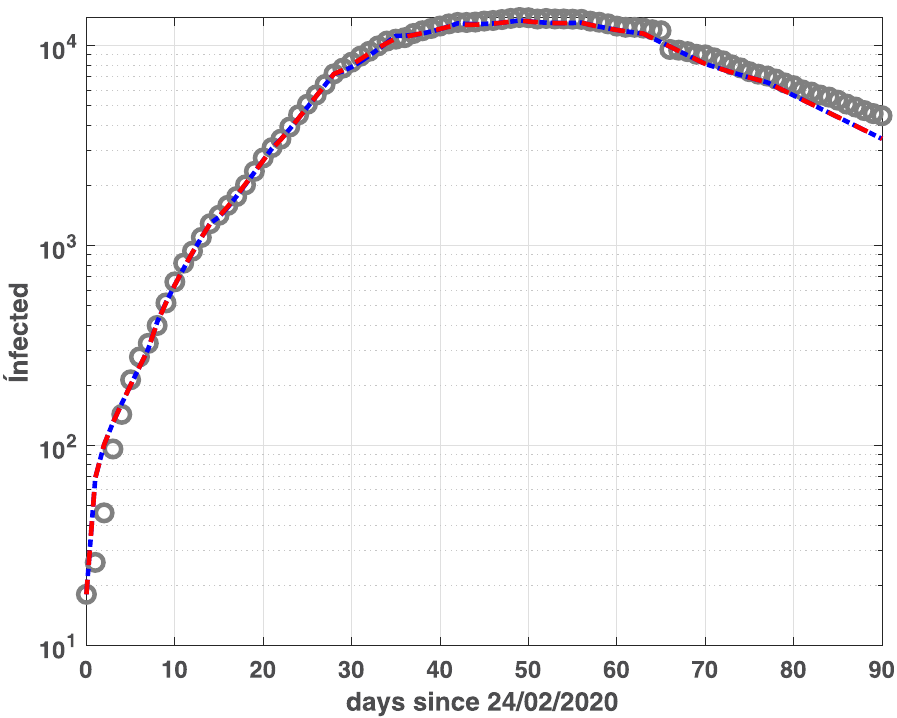
Fig 3. Infected compartments for Emilia-Romagna. Infected data (gray circles) and infected modelled population, obtained by fSEIRDr (blue dash-dotted line) and fSEIDRe (red continuous line).